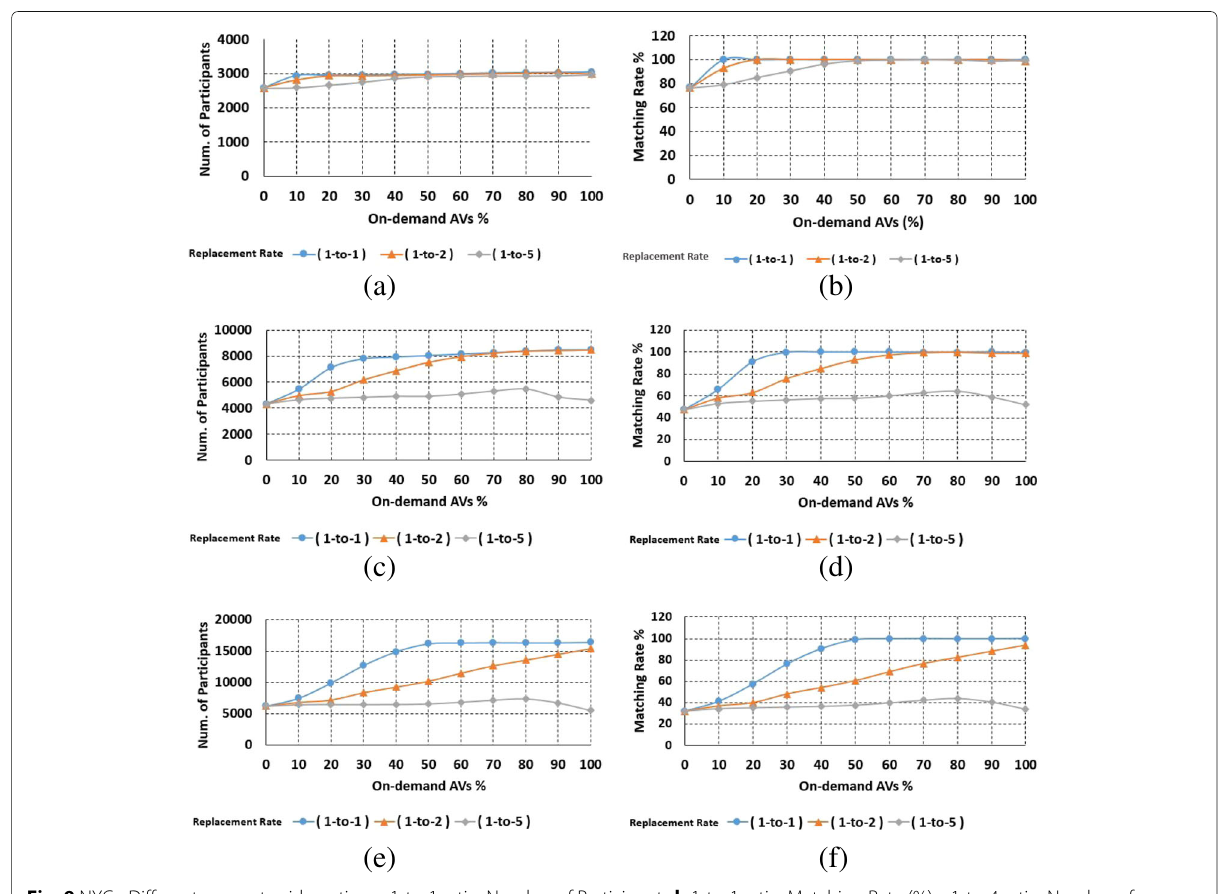
Fig. 9 NYC - Different owner-to-rider ratios. a 1-to-1 ratio, Number of Participants b 1-to-1 ratio, Matching Rate (%) c 1-to-4 ratio, Number of Participants d 1-to-4 ratio, Matching Rate (%) e 1-to-10 ratio, Number of Participants f 1-to-10 ratio, Matching Rate